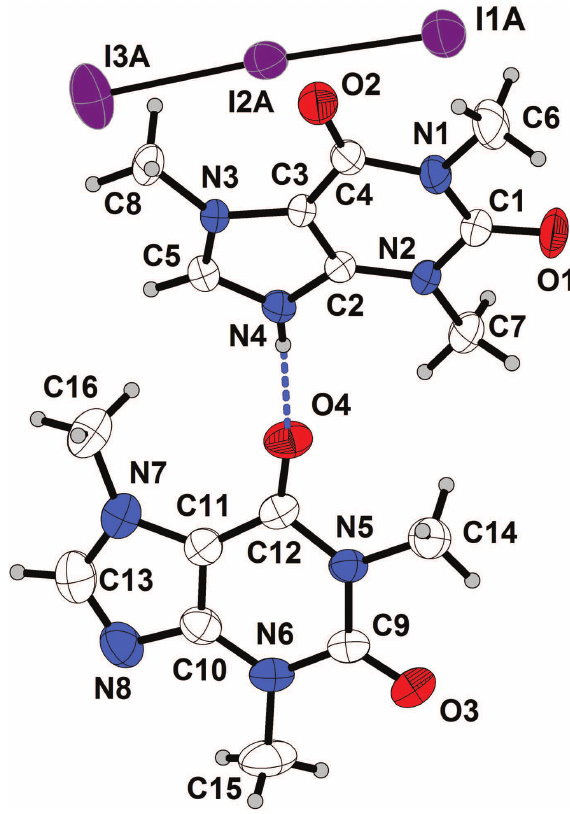
Table 1: Data collection and